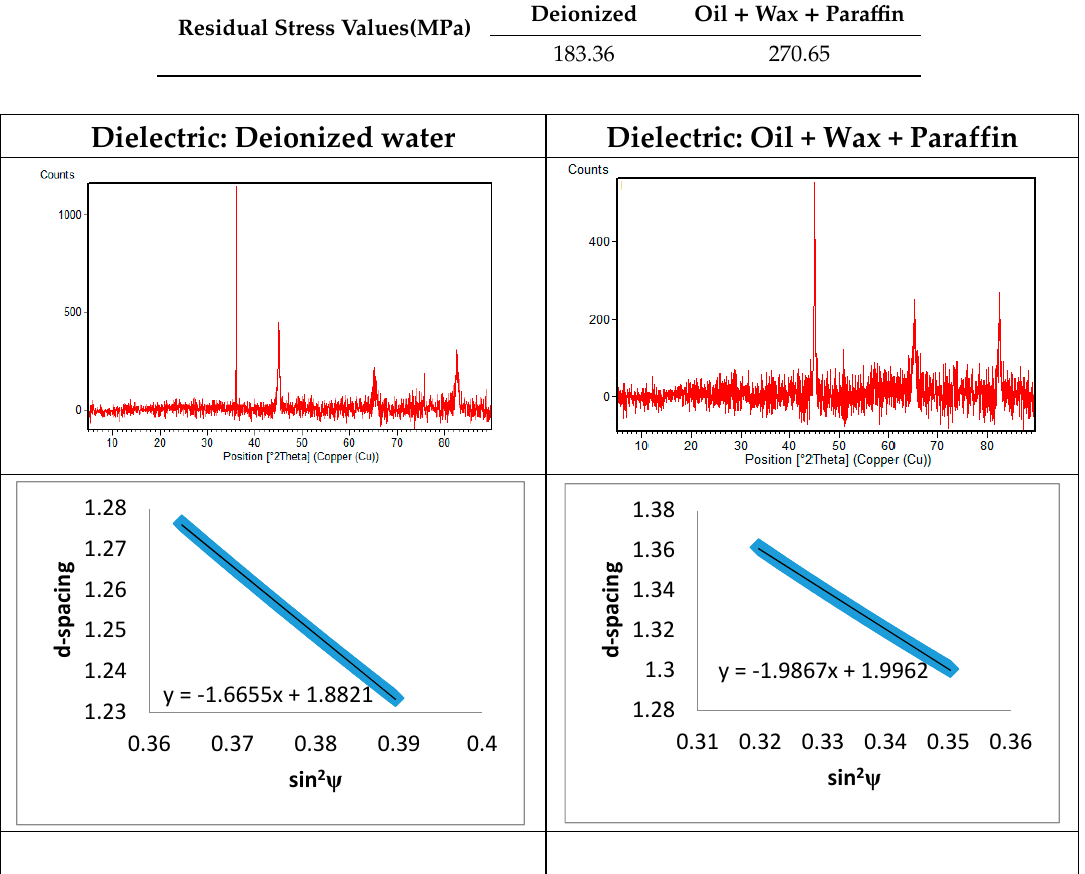
Table 12. Residual stress analysis of wire electrical discharge machined Al-SiC-TiC metal matrix composite.